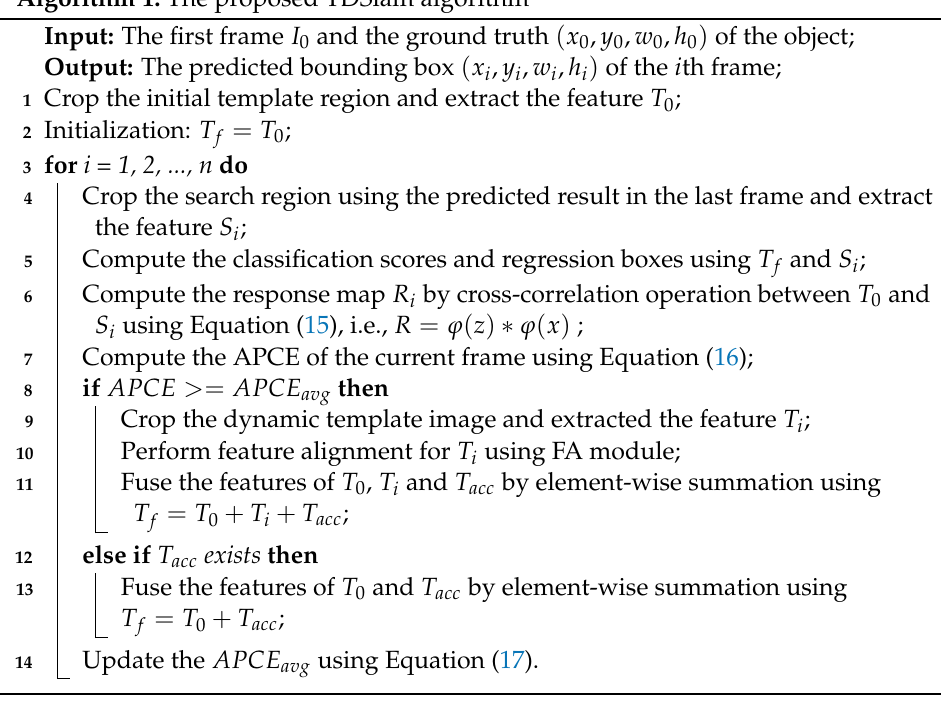
Algorithm 1: The proposed TDSiam